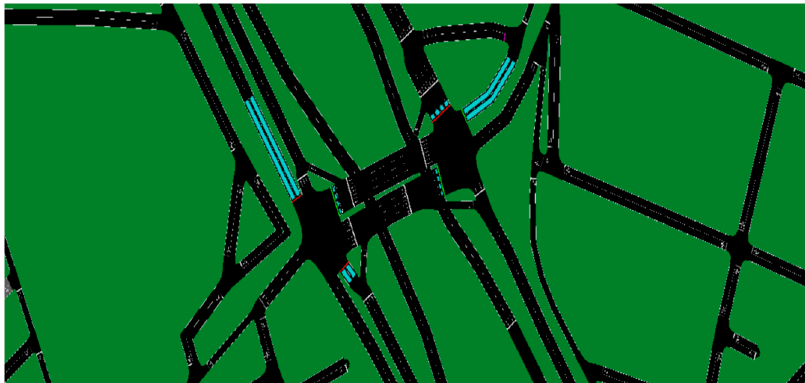
Figure 1. Shiraz traffic network.